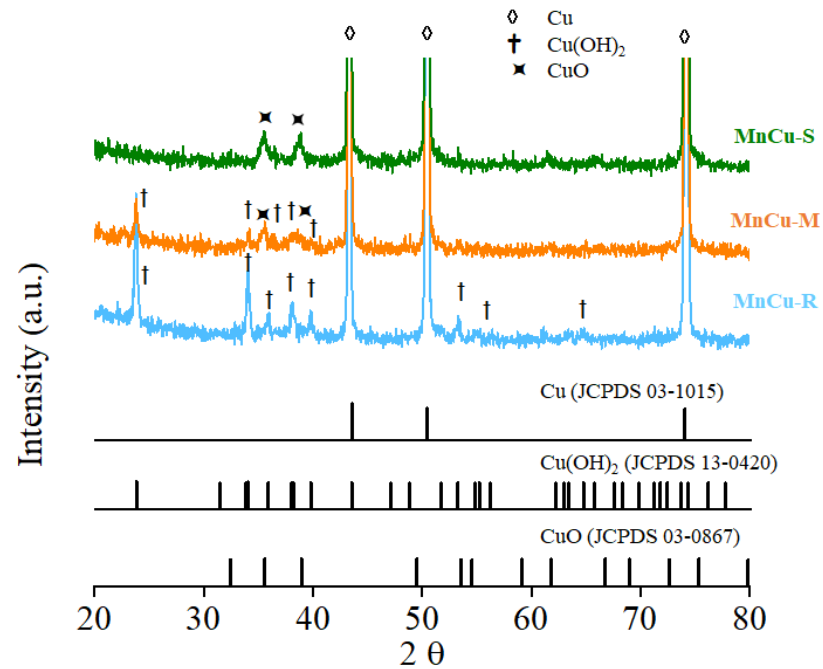
Figure 8. XRD patterns of MnCu-R, MnCu-M, and MnCu-S.